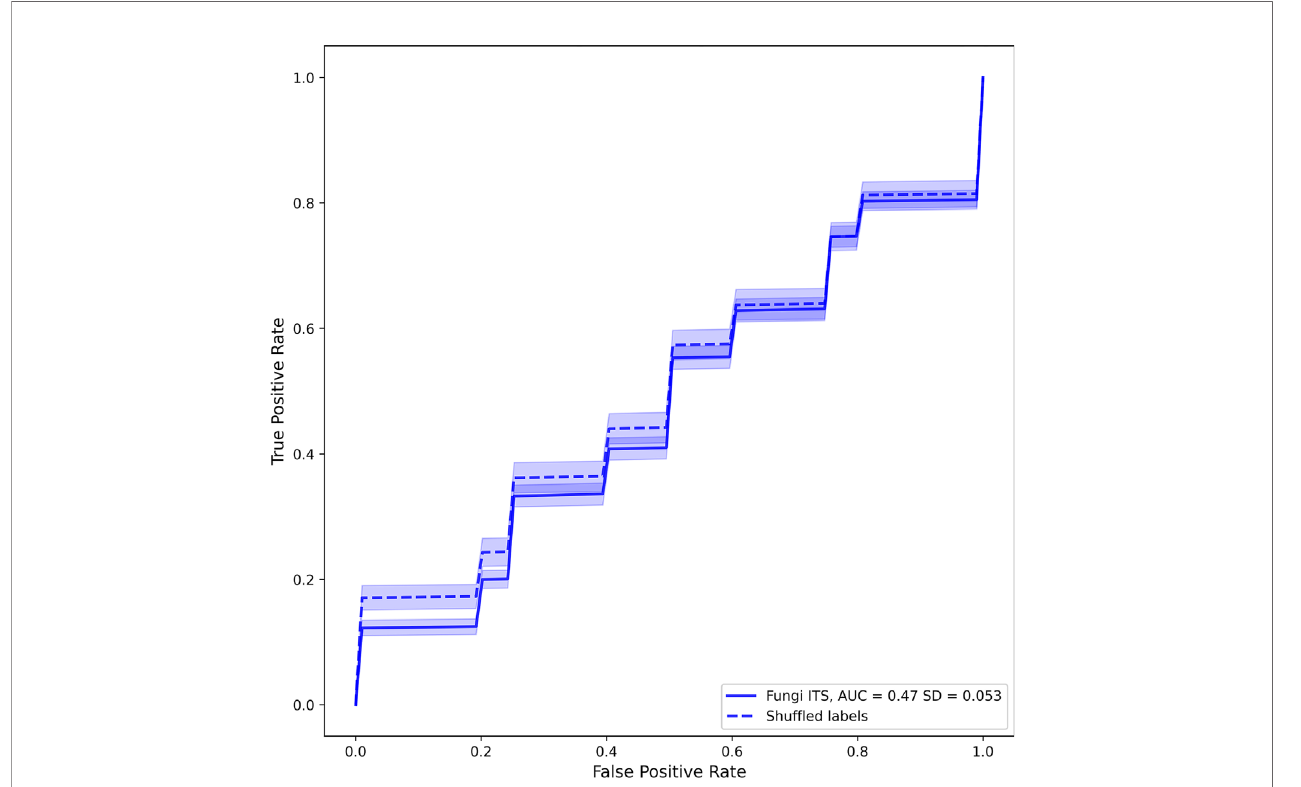
FIGURE 5 | Averaged receiver operating characteristic curves of fungal classi fi ers trained to differentiate positives (PFcase samples) from negatives (control samples). Solid and dashed lines represent real and shuf fl ed labels. Transparent areas around each line represent the 95% con fi dence intervals of the